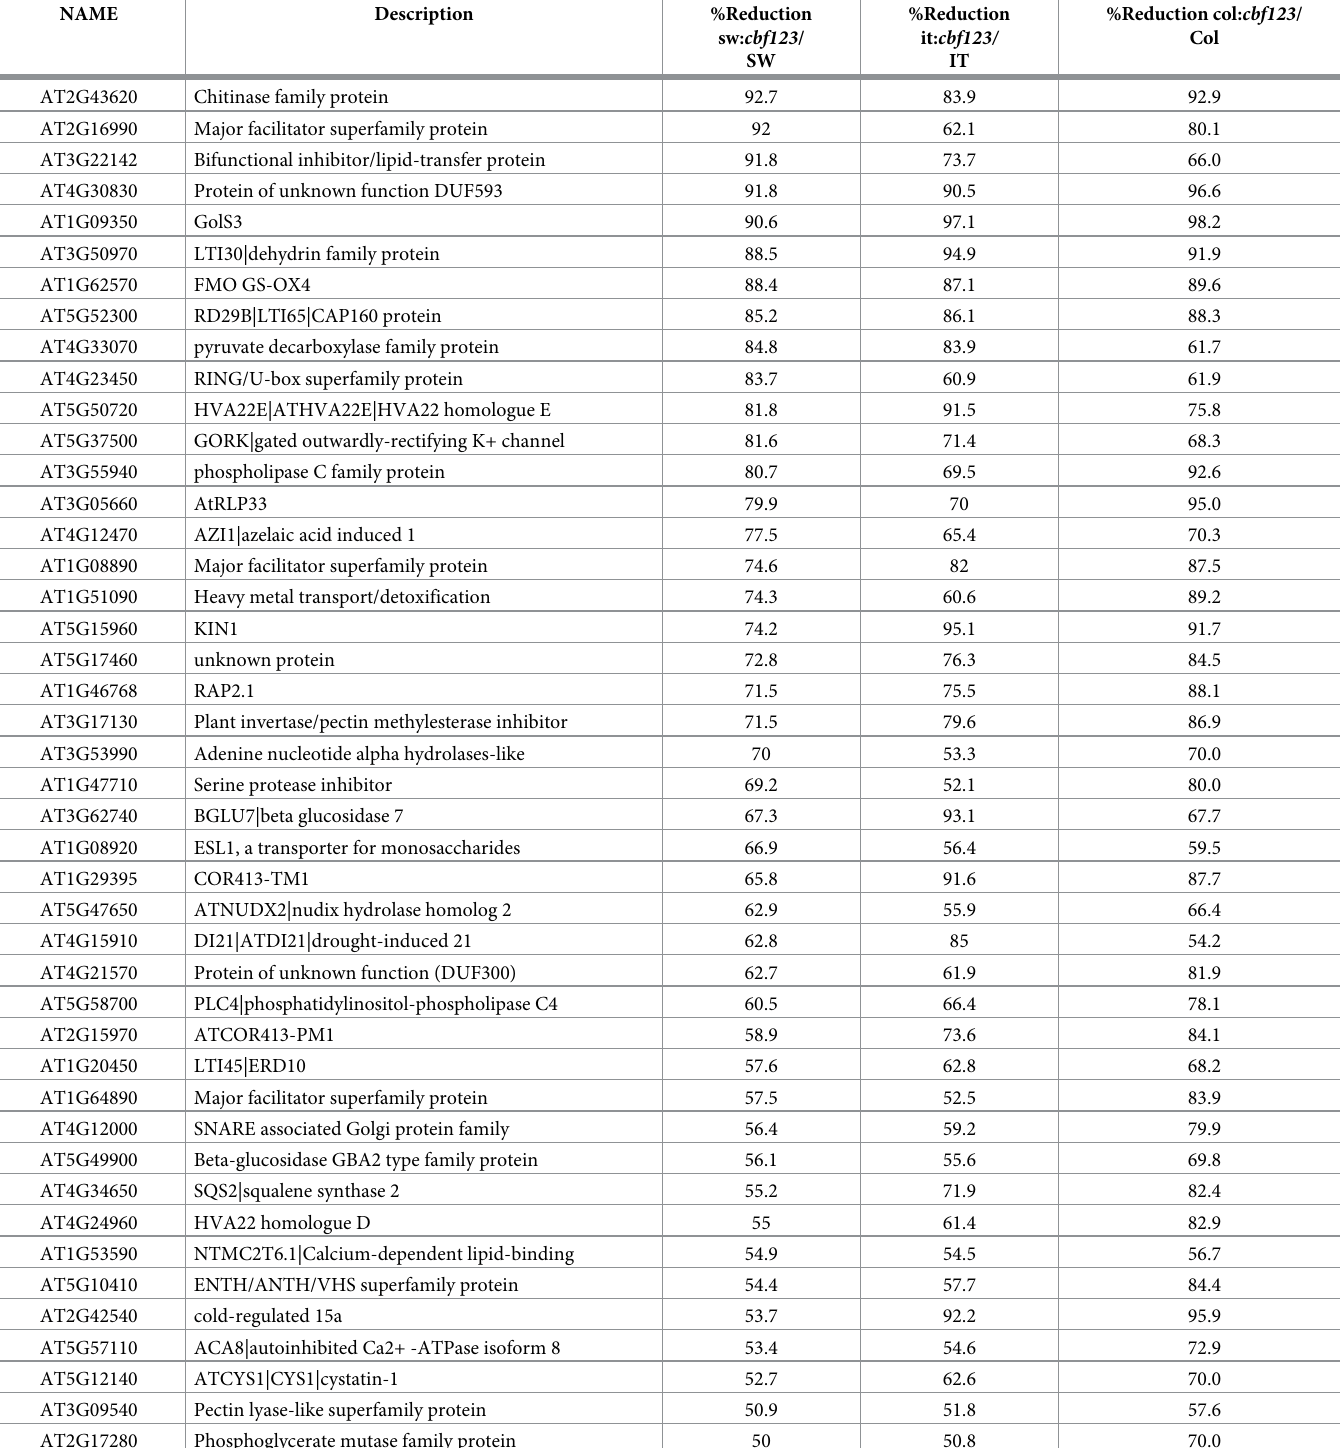
Table 1. CBF regulon genes in common between the SW, IT, and Col-0 genotypes.